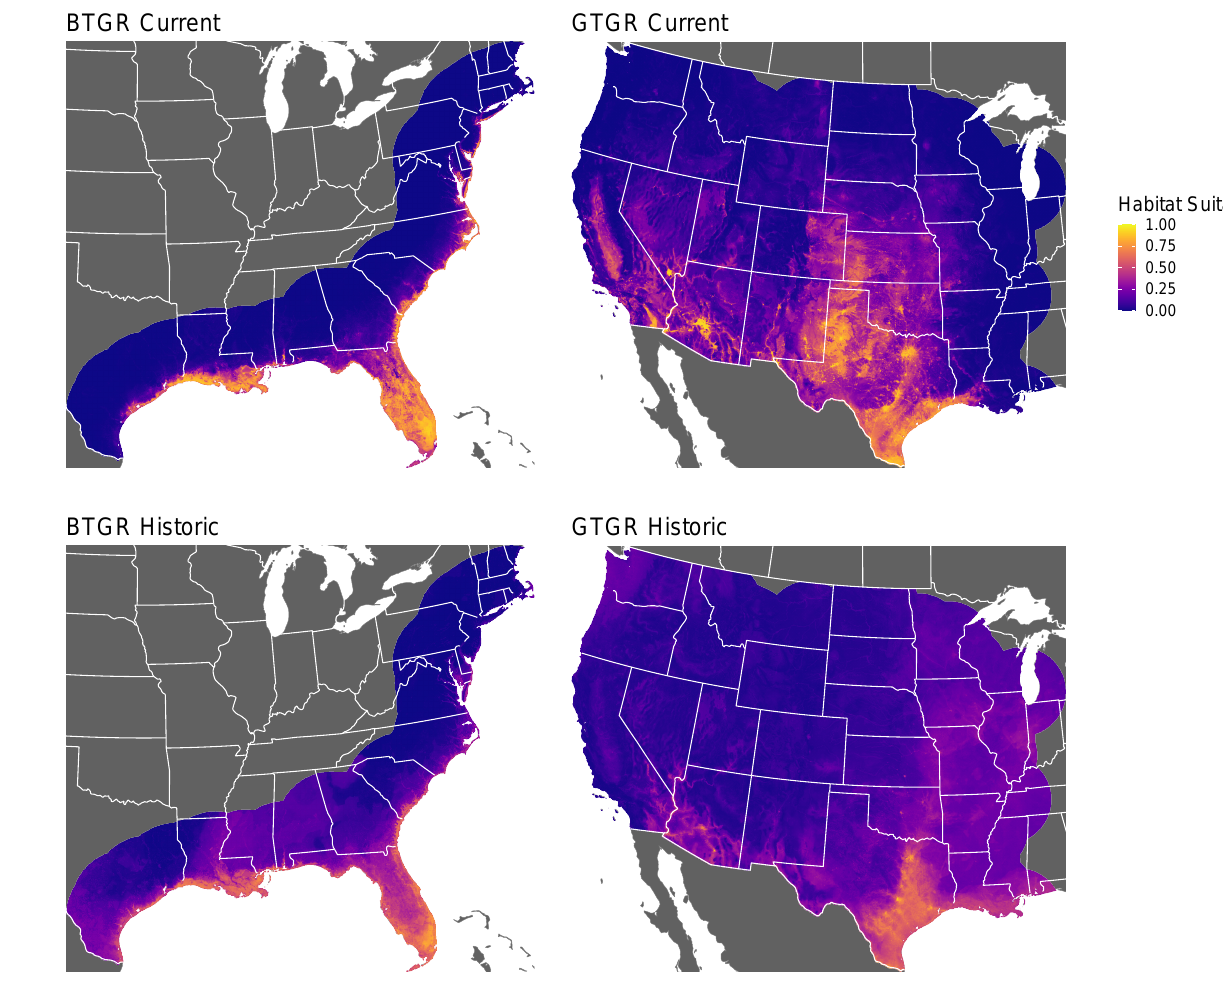
Supplementary Figure 2 – Predicted habitat suitability using random forest models for boat-tailed grackles (BTGR) and great-tailed grackles (GTGR). Brighter colors indicate higher habitat suitability. The presented results are the average of the 10